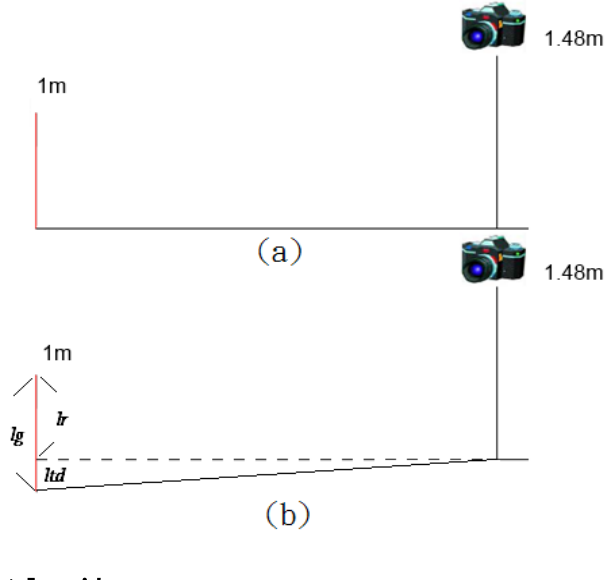
Figure 3. The object photography schematic diagram: ( a ) image captured by the camera on flat ground; ( b ) image captured by the camera on the railway crossing with a terrain drop